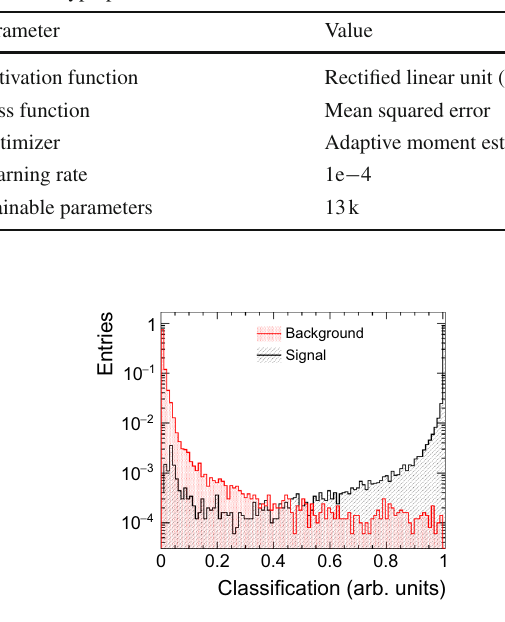
Fig. 3 MLP classification distribution for signal and background